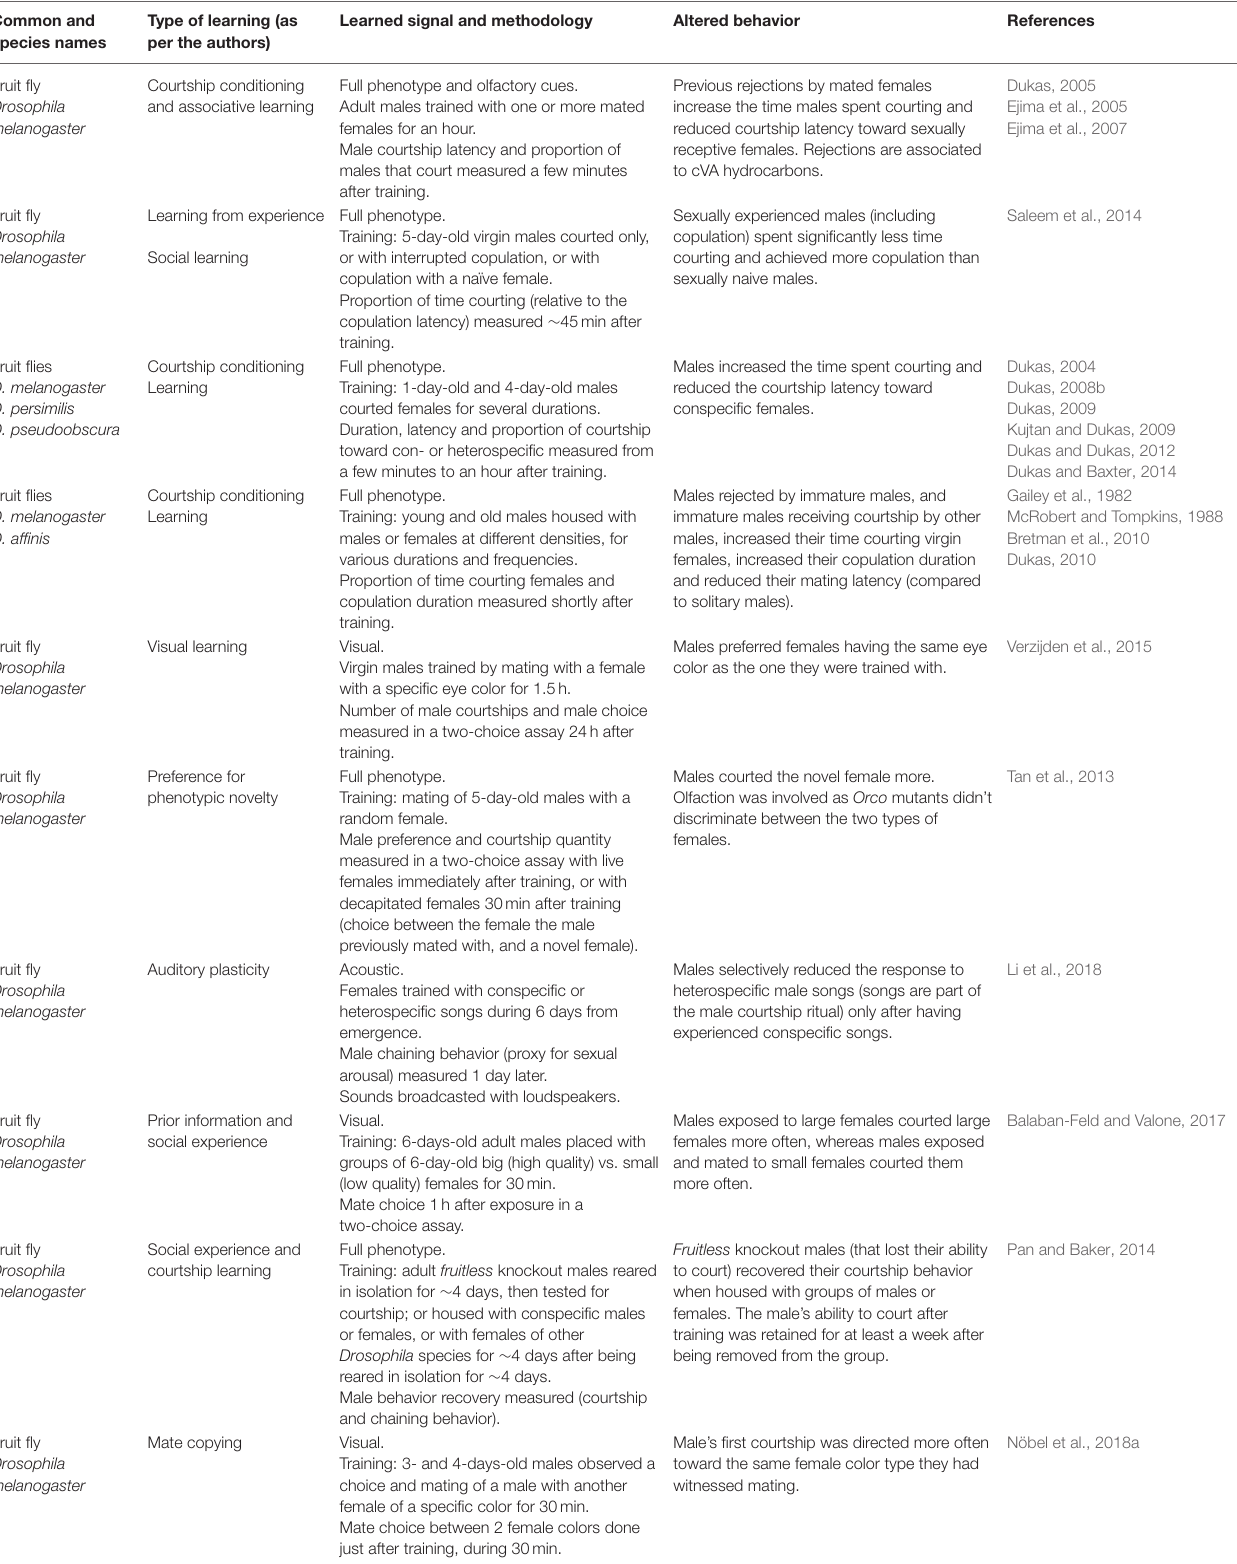
TABLE 1 | A non-exhaustive list of publications about how male insects and spiders learn sexual behaviors. Common and species